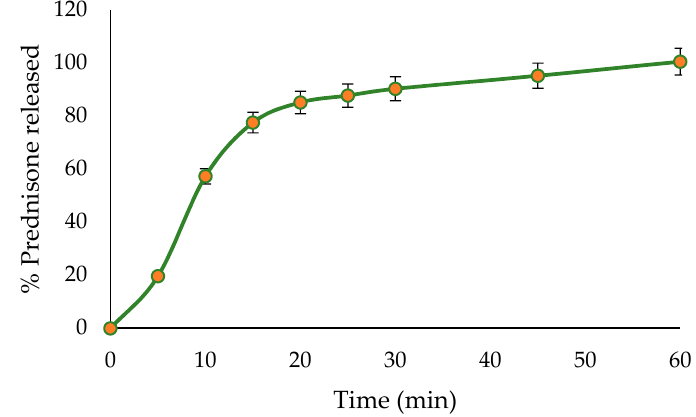
Figure 5. In-vitro release profile from optimized prednisone pellets ( n = 3).